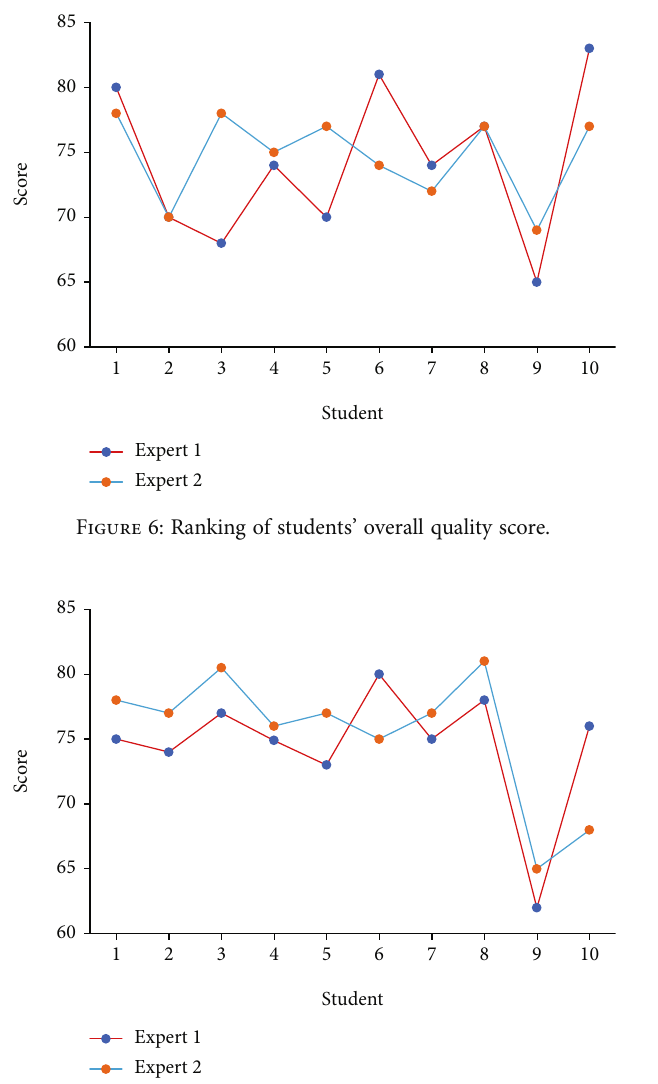
Figure 7: The total score of students ’ comprehensive quality in the multilevel fuzzy comprehensive